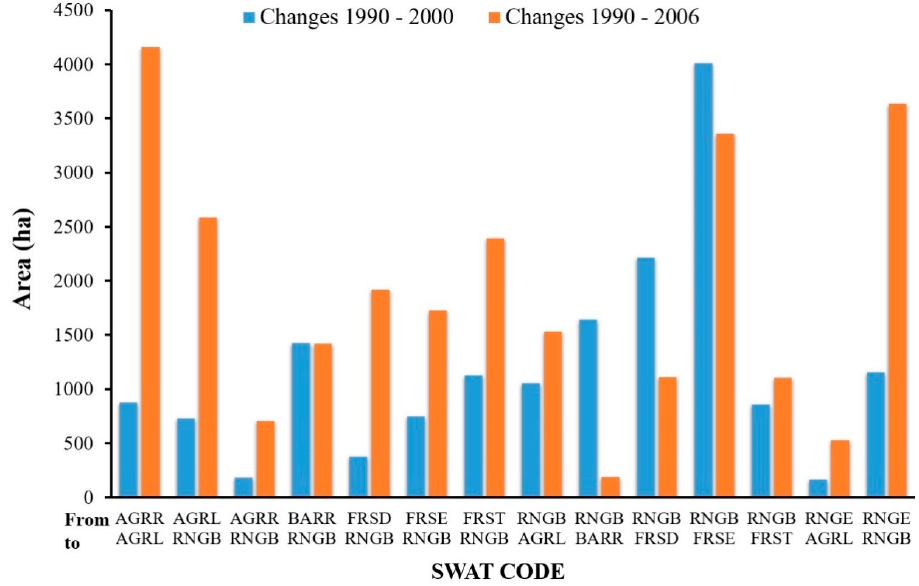
Figure 3. Graphic of changes between the CORINE Land Cover in 1990 and 2000, and between the CORINE Land Cover in 1990 and 2006 in the Sabor river Basin. Only the areas with changes greater than 500 hectares are presented. The SWAT codes are agricultural land—row crops (AGRR), agricultural land—generic (AGRL), range—brush (RNGB), range—grasses (RNGE), barren (BARR), forest—deciduous (FRSD), forest—evergreen (FRSE), and forest—mixed (FRST).